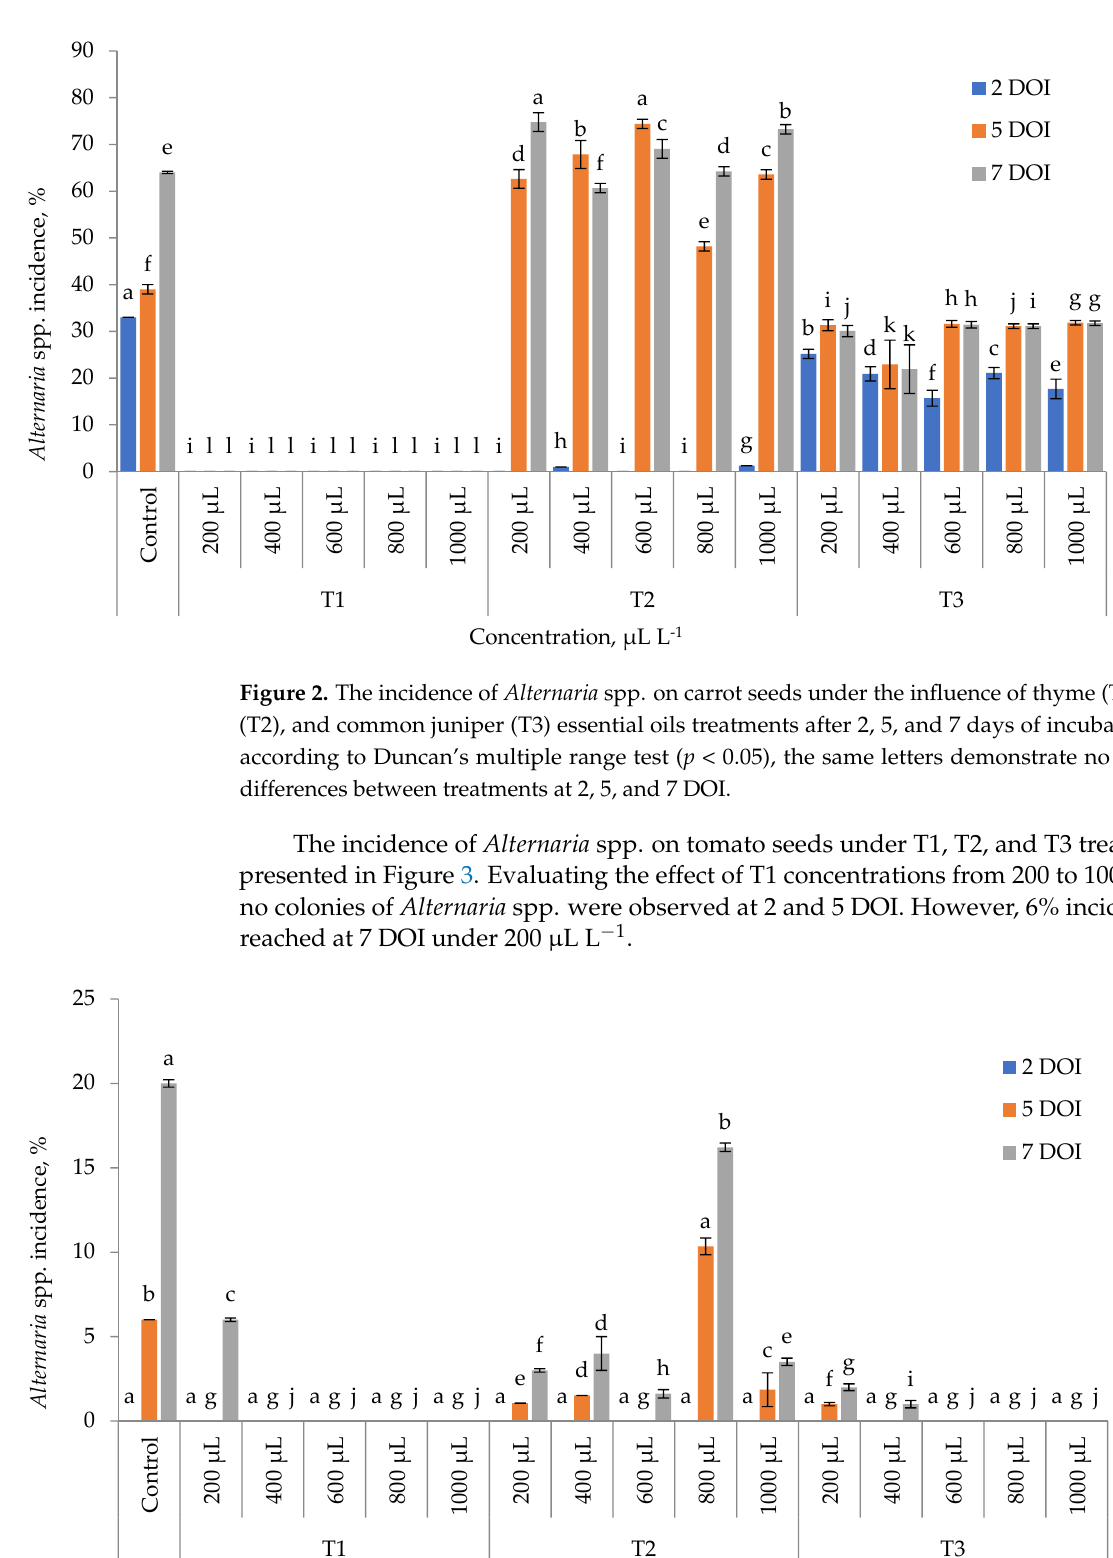
no colonies of Alternaria spp. were observed at 2 and 5 DOI. However, 6% incidence was reached at 7 DOI under 200 μ L L − 1 .